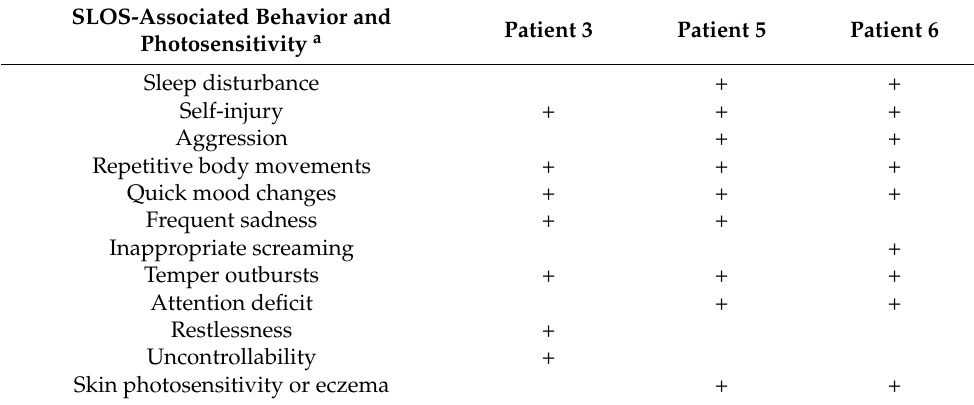
Table 1. Behavioral problems showing improvement following vitamin E